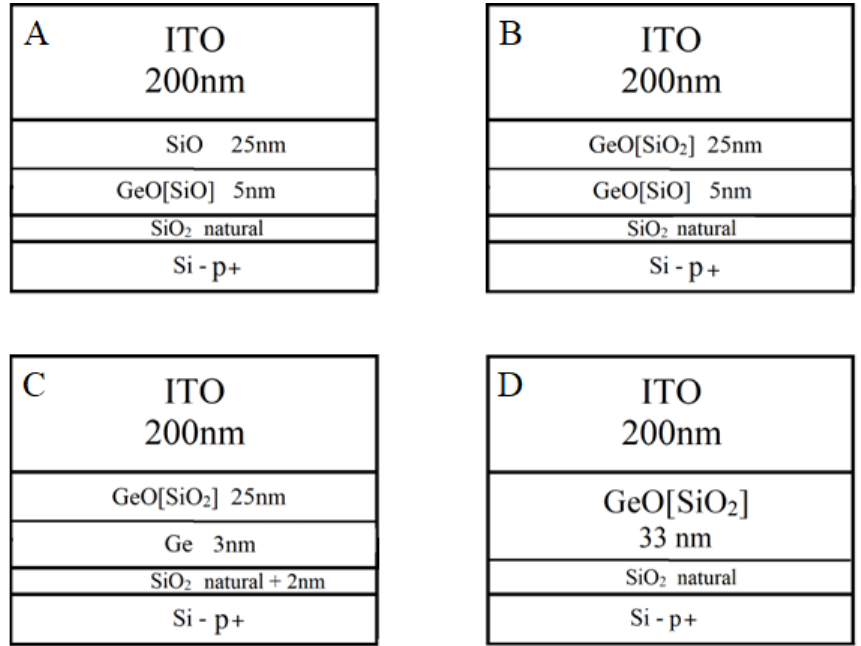
Figure 2. Survey spectrum of X-ray photoelectrons for a film obtained by the co-evaporation of GeO 2 and SiO 2 powders. The survey spectrum was obtained at a fixed analyzer transmission energy of 50 eV. As can be seen, intense photoelectron peaks are observed in the spectrum. These peaks are specific for germanium, silicon, oxygen, and carbon. Since the samples are stored in a normal atmosphere, the surface always contains organic materials as an impurity. The organic materials contain carbon and oxygen. Specifics for other element peaks were not